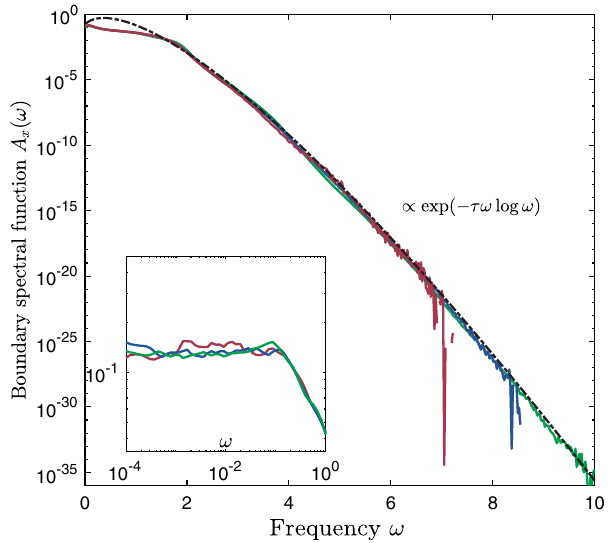
FIG. 1. Boundary spectrum. The high-frequency part of the spectral function of the S x 1 operator on the boundary of a chain of length L ¼ 12 , 14, 16 is shown in red, blue, and green, ω Þ ∝ exp ½ − τω log ð ω Þ(cid:2) respectively. The dashed line shows a A x ð fit, indicating the spectral function saturates the bound expected for one-dimensional chaotic systems. The inset shows the low- frequency part of the spectral function, showing a clear plateau indicative of random matrix